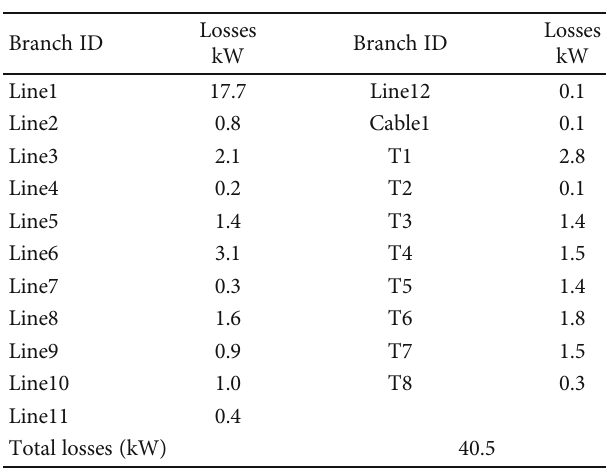
Table 9: Branch losses for Case 2.